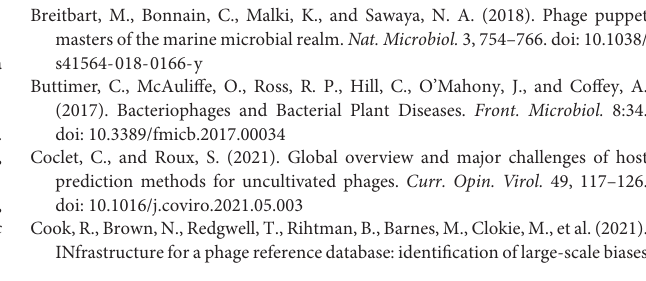
Supplementary Figure 1 | Overview of the methods implemented in the PHD web application to collect information regarding interactions between viruses and prokaryotic host species. (1) Names and/or NCBI taxonomy identifiers (taxIds) of hosts are extracted from nucleotide/protein sequence records of viruses available in six source databases (NCBI Virus, RefSeq, Virus-Host DB, MVP, UniProt-SwissProt, and IntAct). (2) The extracted host names/taxIds are queried in TaxonKit against NCBI Taxonomy to retrieve full taxonomic lineages of hosts including their names, ranks, and taxIds. Only prokaryotic host species from Bacteria or Archaea are included in further steps. (3) Additional taxonomic information (if available) for each prokaryotic host species is retrieved from the Genome Taxonomy Database (GTDB). (4) Interaction assignments between virus sequence records and the prokaryotic host species are collected from the source databases. (5) Virus taxIds provided in sequence records are used to retrieve virus taxonomic lineages from NCBI Taxonomy. The obtained virus species taxIds or sequence accessions are used to retrieve virus taxonomic lineages (if available) in the International Committee on Taxonomy of Viruses (ICTV). Sequence accessions are then assigned to the appropriate virus species. For example, three genomic sequences (MN125599, MN125600, and NC_049813) belong to the Veterinaerplatzvirus vv12210I species. (6) Sequence accessions within virus species are grouped into genome assemblies based on metadata provided in the NCBI Assembly database. For example, two sequence accessions - MN125599, MN125600 - are part of one genome assembly from GenBank